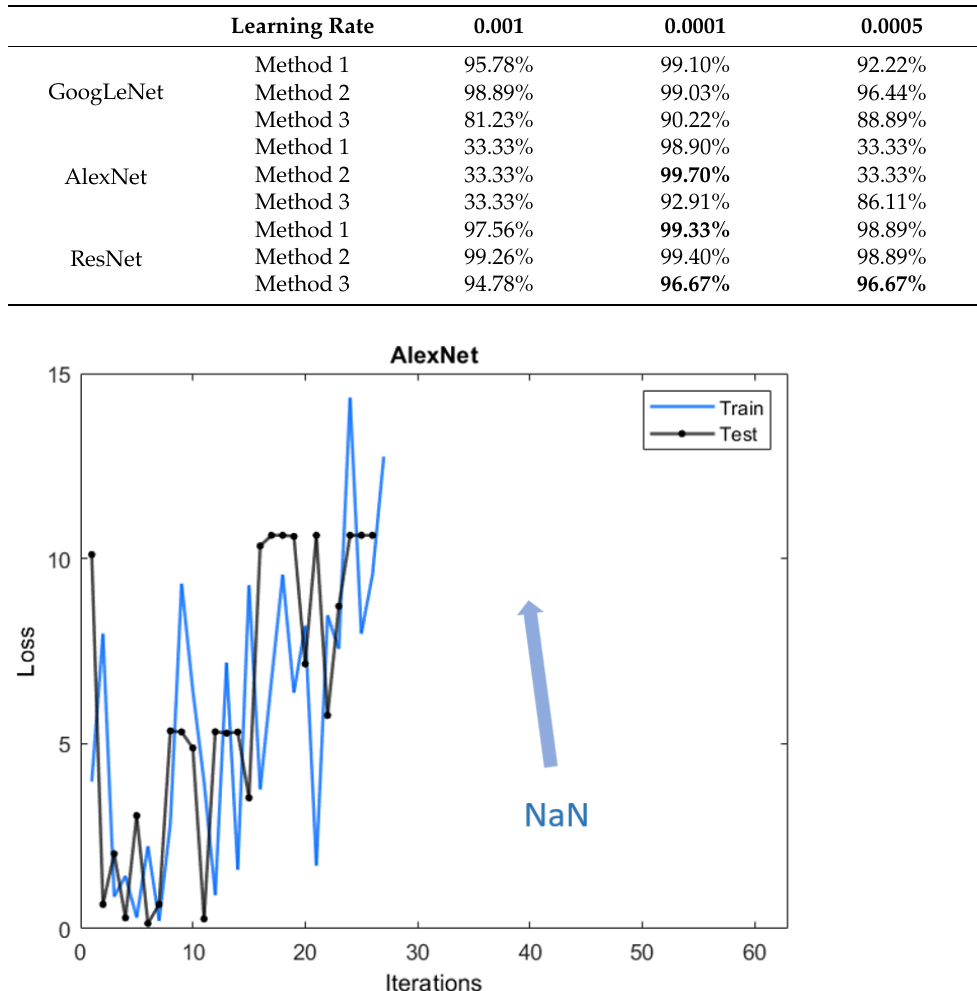
Figure 18. Loss curve of AlexNet with a learning rate of 0.001.